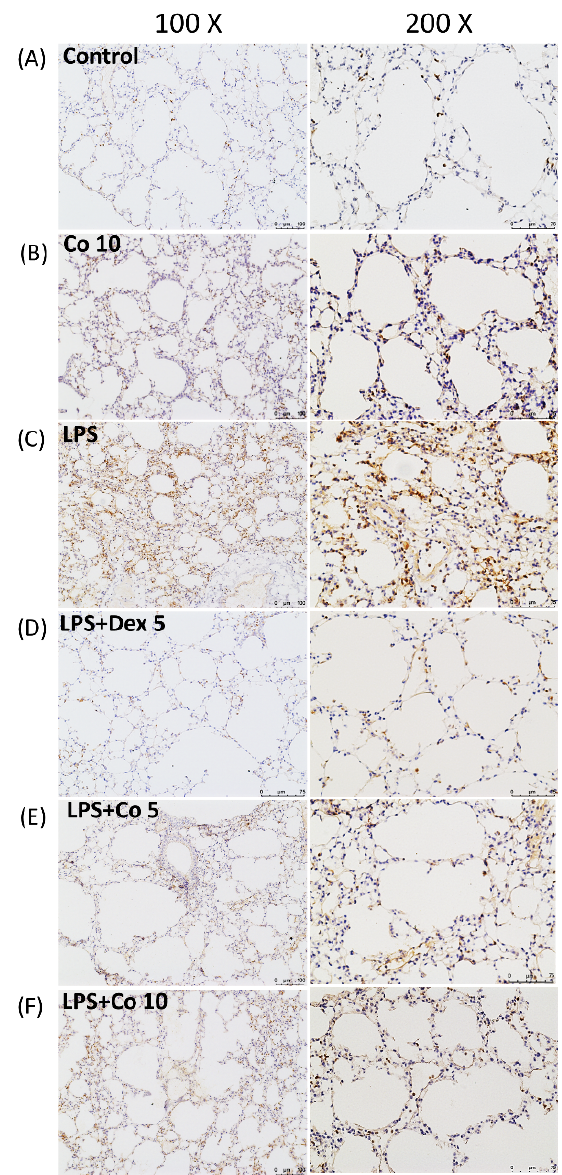
Figure 3. Effects of corilagin on neutrophil infiltrations in LPS-induced ALI . After intratracheal LPS challenge for 30 min, the mice were administered with Dex (5 mg/kg), corilagin (5 and 10 mg/kg), or equal volume of saline intraperitoneally. Mice were sacrificed after 6 h of LPS challenge for analysis by immunohistochemical staining. Lung tissues were immunostained with anti–Ly6G antibody (brown). Typical images were chosen from each group: ( A ) normal saline (control), ( B ) corilagin (10 mg/kg) only, ( C ) LPS, ( D ) LPS + dexamethasone (5 mg/kg), ( E ) LPS + corilagin (5 mg/kg), and ( F ) LPS + corilagin (10 mg/kg). (100 × and 200 × magnifications are shown).